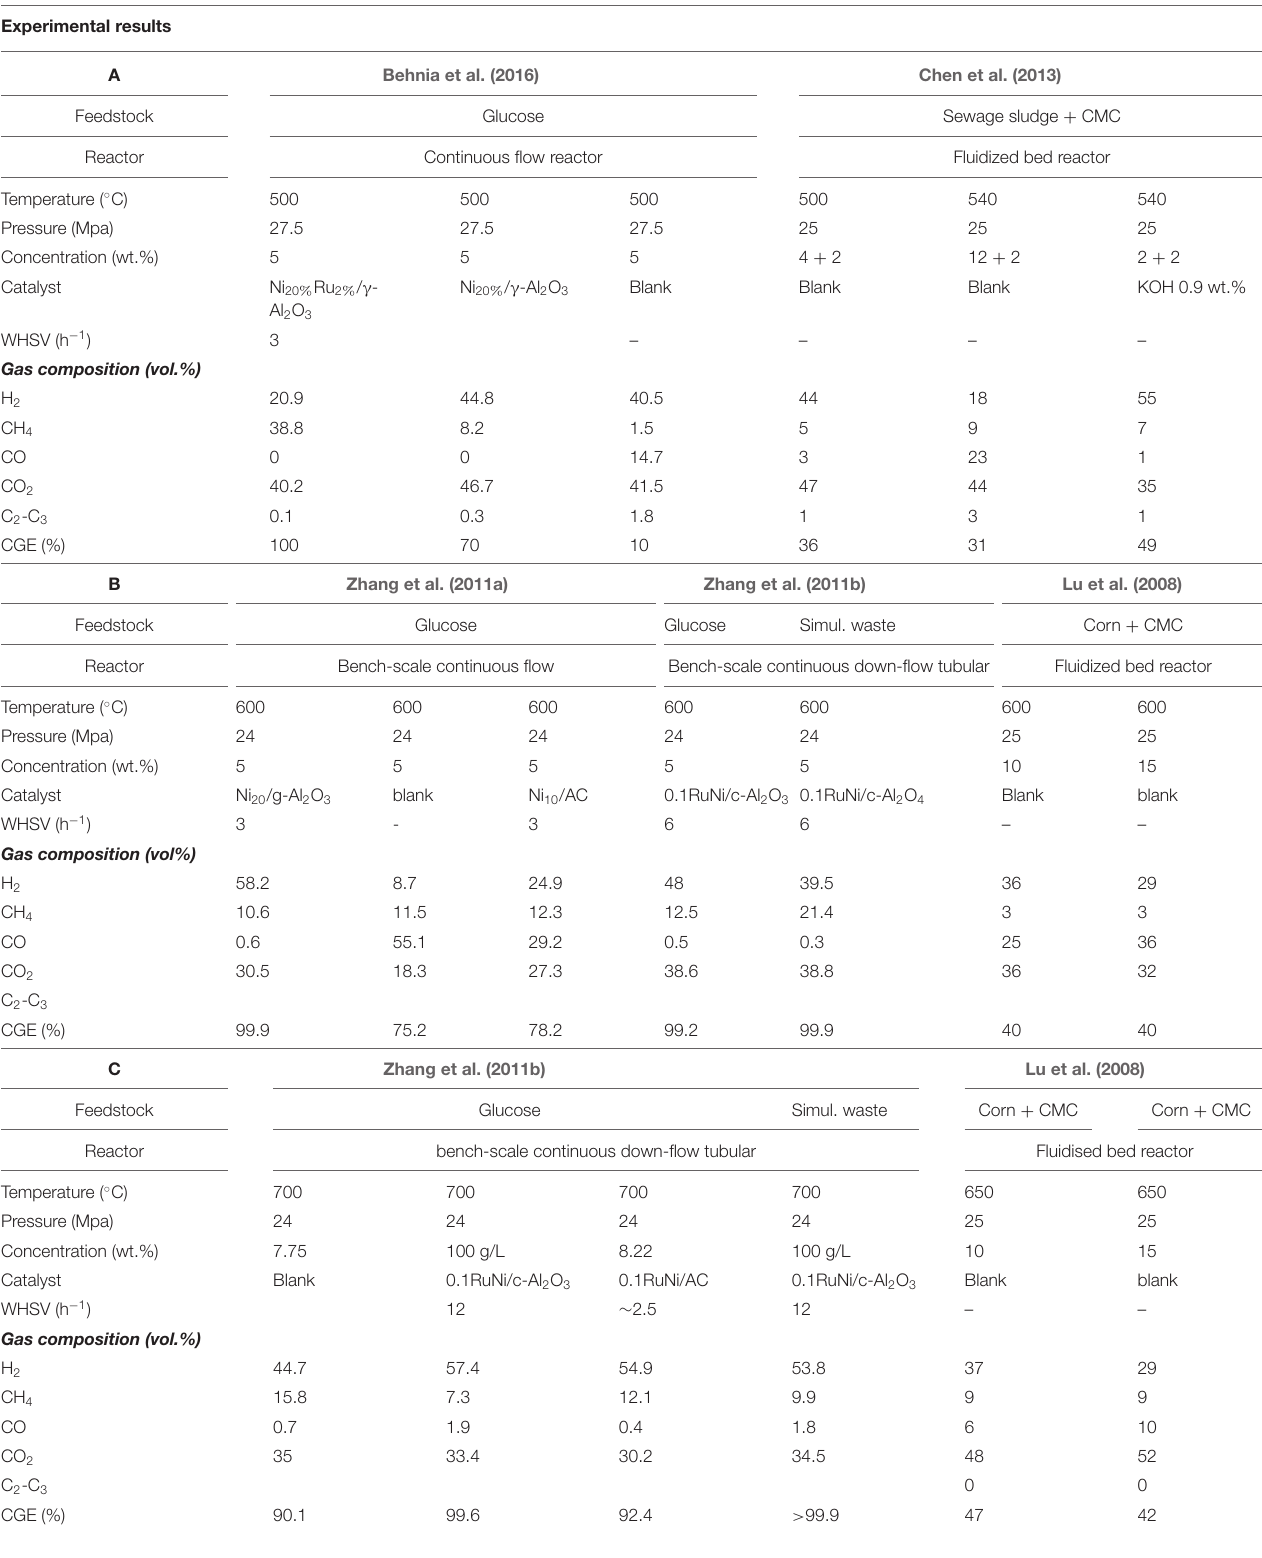
TABLE 1 | Comparison of gas composition and carbon gasification efficiencies of various feedstock from supercritical water gasification (SCWG) and SCWG experimental investigations. Experimental results A